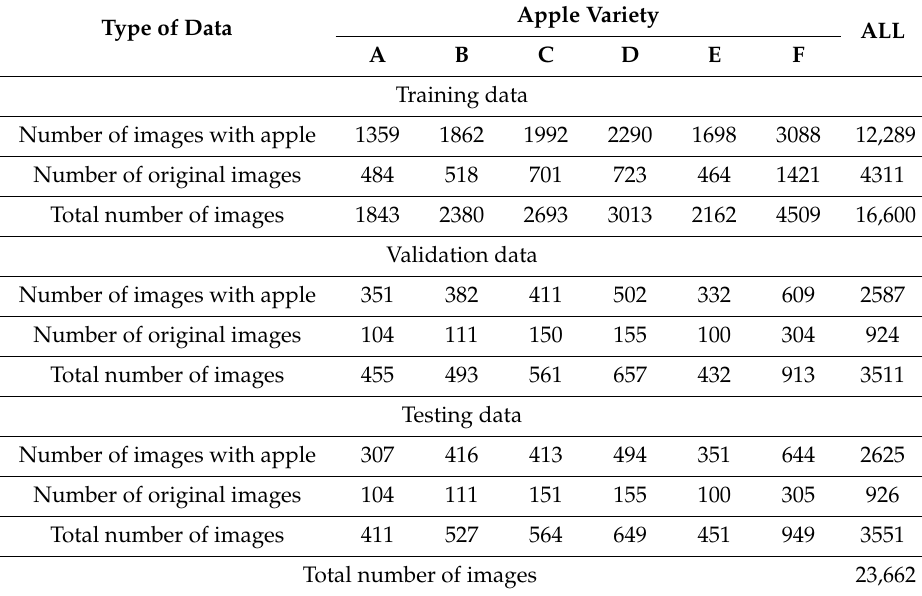
Table 3. Dataset structure considered in the research.